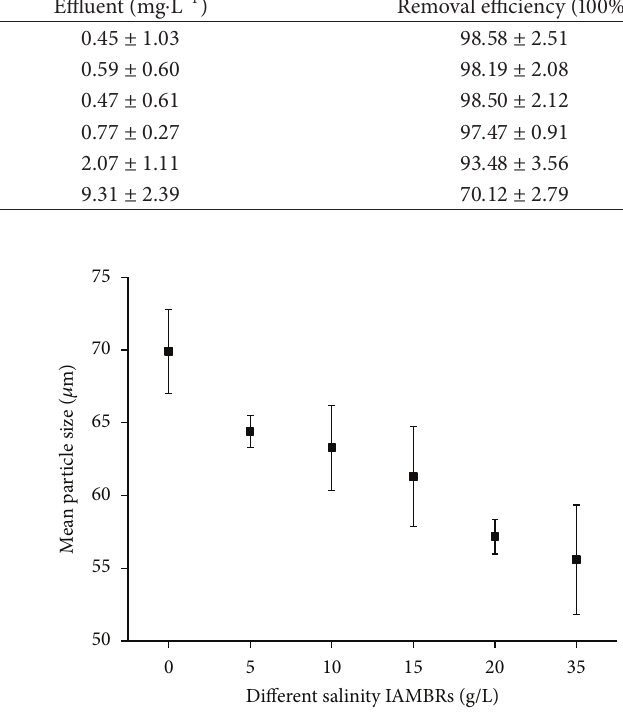
Figure 3: The variation of PSD at different